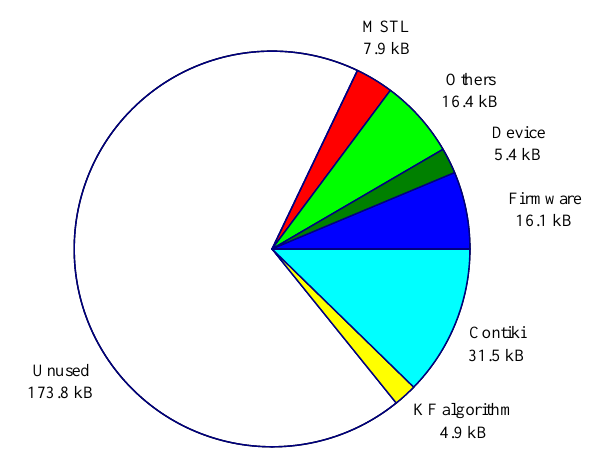
KF algorithm 4.9